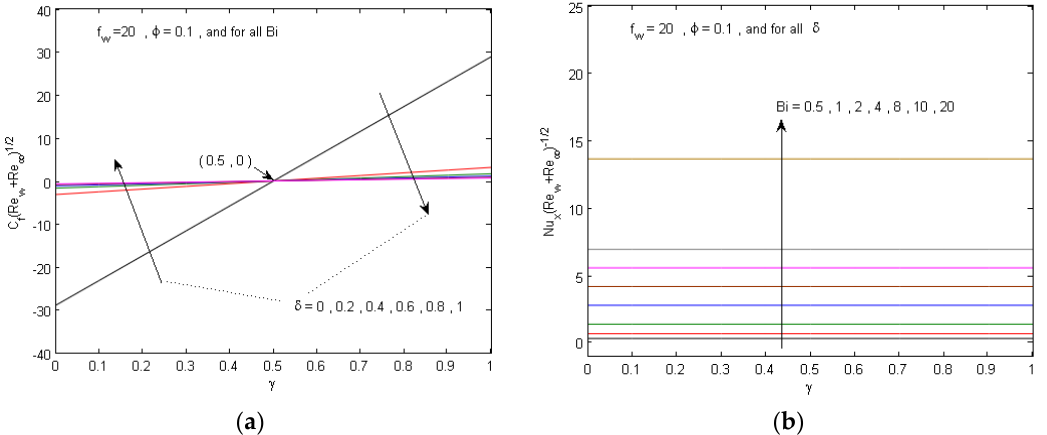
Figure 11. ( a ) Local skin friction coefficient for various values of slip parameter δ and ( b ) local Nusselt number for various values of Biot number Bi .